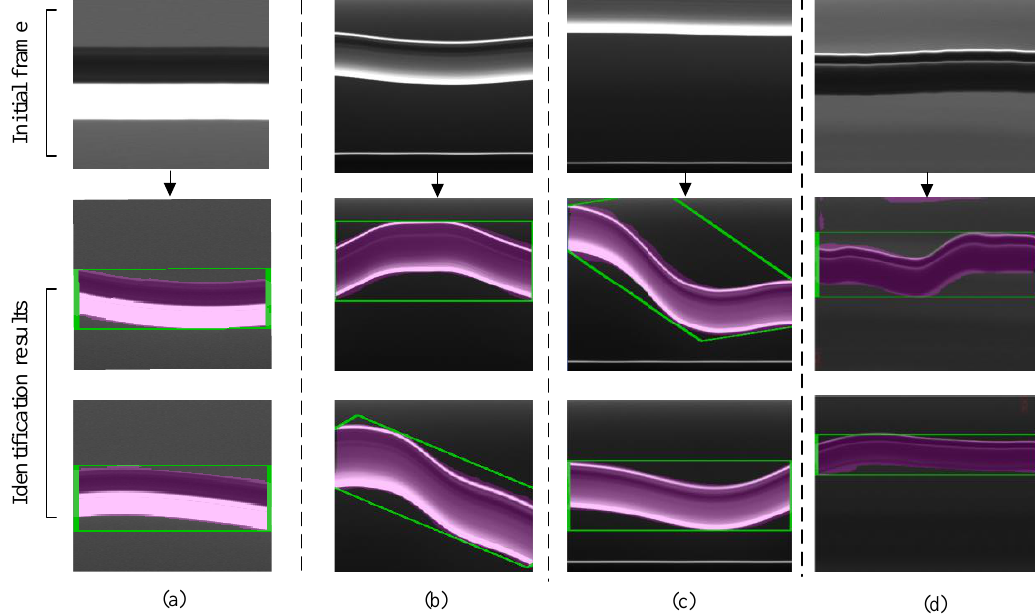
Figure 12. Contact wire vibration images obtained under different conditions. ( a ) Contact wire images obtained from the laboratory test. ( b , c ) Contact wire images from the field test under strong lighting conditions and different kinds of impact. ( d ) Contact wire images obtained from the field test under the weak lighting condition.